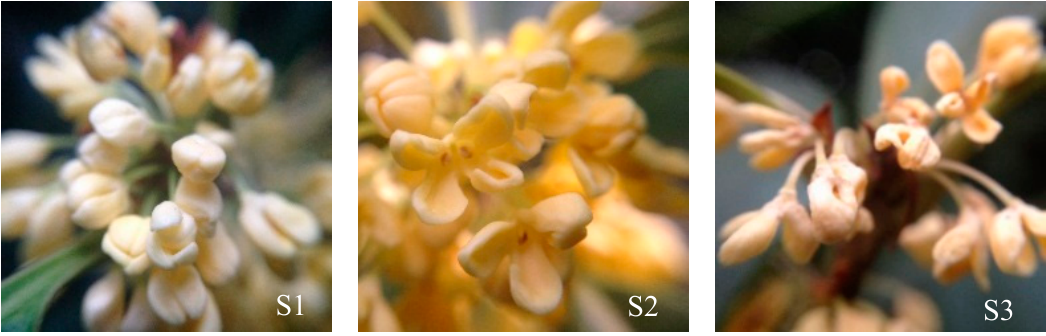
Figure 1. Photographs of flowers at different flowering stages: ( S1 ): Initial flowering stage, ( S2 ): Full flowering stage, and ( S3 ): Final flowering stage. Table 1. The Summary of the O. fragrans transcriptome.